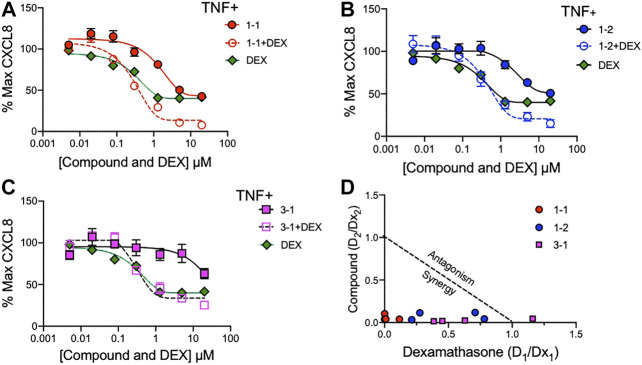
Synergistic effects of lead compounds with DEX in suppressing TNF stimulated CXCL8 production. Compounds 1–1; (A), 1–2; (B) and 3–1; (C) and DEX were titrated to the indicated concentrations and added to TNF 2 ng/ml stimulated THP-1 cells overnight and CXCL8 measured in the supernatant. Vehicle was 0.04% DMSO. Data are represented as mean ± SEM. (D) Potency ratios were calculated and presented as isobolograms. The dotted line represents additivity between DEX and the compounds. Data are representative of two independent experiments showing similar results.